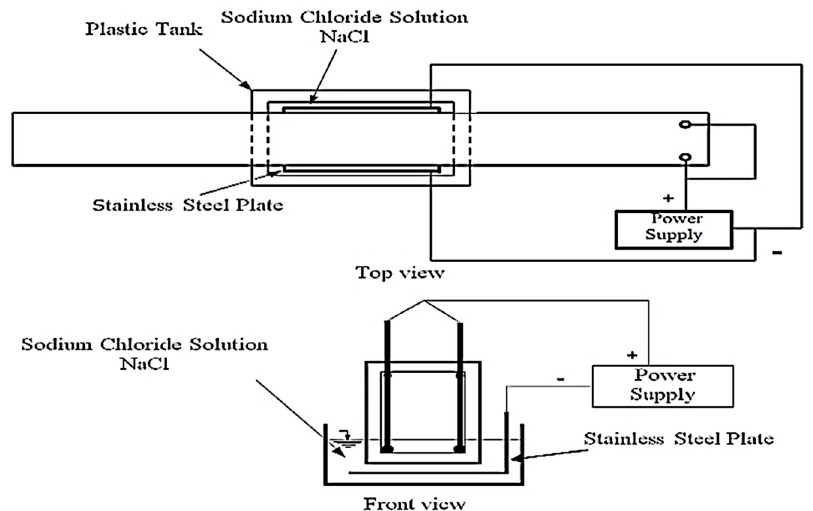
Figure 2. Details setup of the accelerated process.